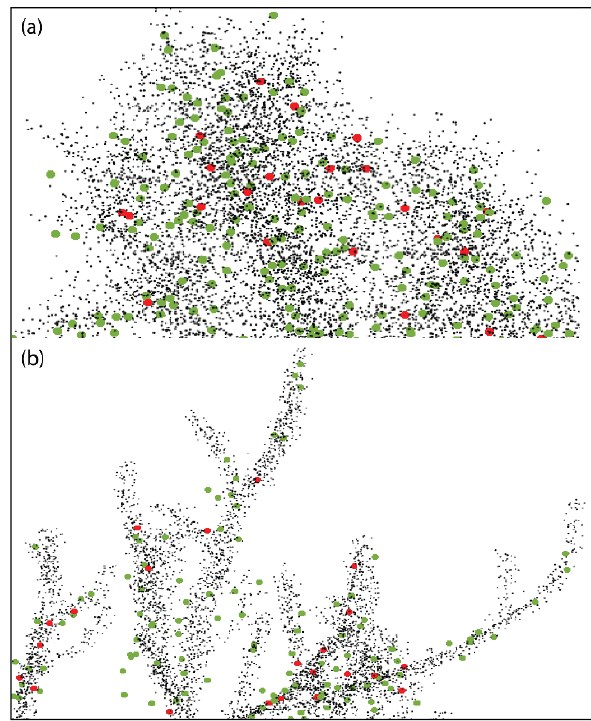
Figure 7. (a) Tree with dense crown structure; (b) Tree sample with protruding single branches; black: ULS; green: ALB; red: ALS